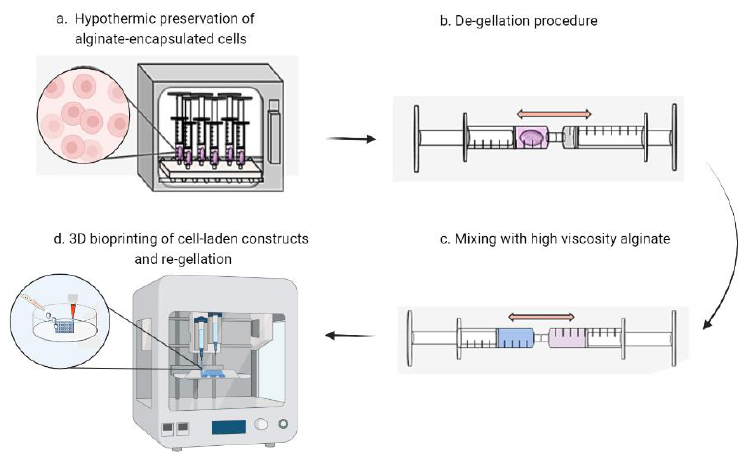
Figure 1. Schematic illustrating the process for printing stored cells. ( a ) hASCs encapsulated in BeadReady™ are stored for 1 week at controlled room temperature. ( b ) Alginate beads containing cells are dissolved using sodium citrate. ( c ) High viscosity alginate (HV-alginate) is mixed with the dissolved gel to increase ink viscosity. ( d ) Cell-laden bioink is extruded using a bioprinter and re-gelled using calcium chloride. Figure created with BioRender.com.